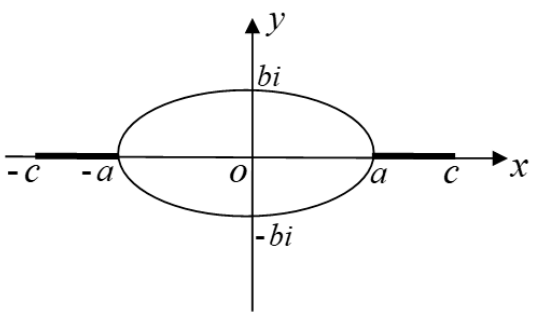
Figure 3. A model of two dimensional quasicrystals with an elliptical hole with double cracks.